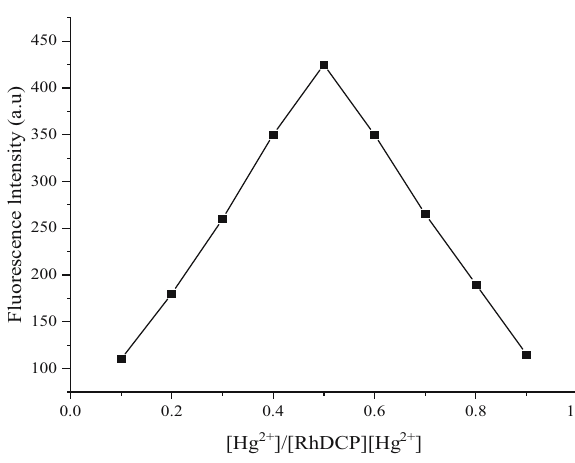
Figure 3: Determination of the binding ratio ( CH 3 CH 2 OH/H 2 O [ v/v, 1/2 ] , λ ex = 530 nm ) ; the fl uorescent system by the equimolar method.